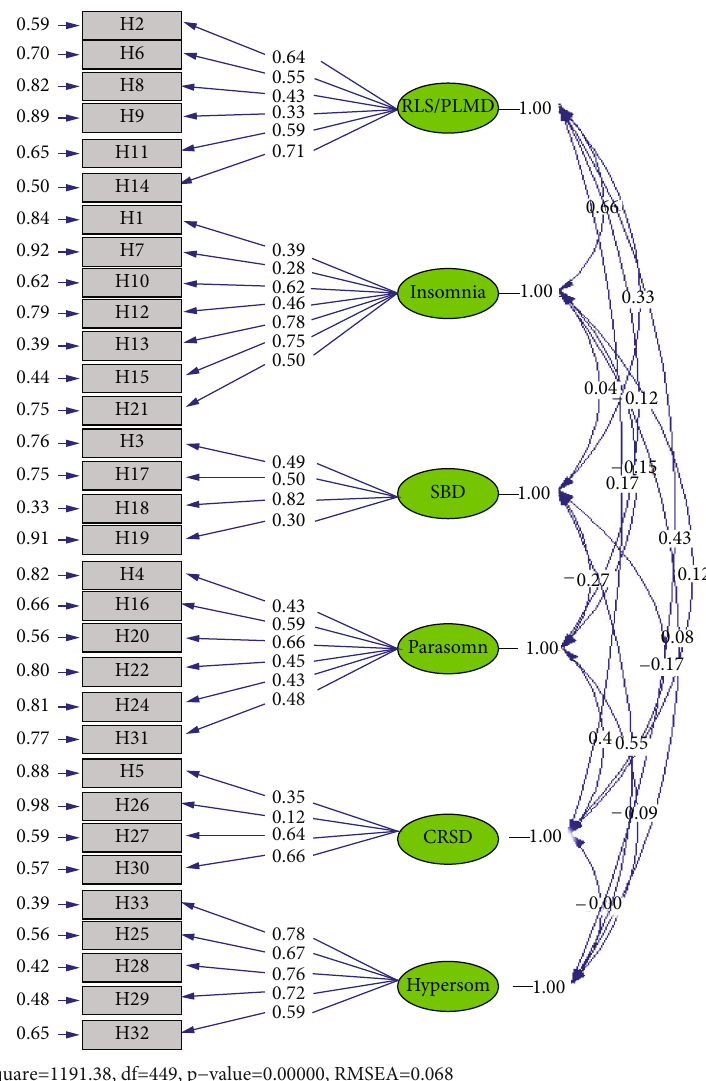
Figure 2: The six-factor model of the HSDQ in the Iranian population standard. CRSD: Circadian rhythm sleep disorders, RLS: restless legs syndrome, PLMD: periodic limb movement disorder; SDB: sleep-disordered breathing; HGDQ: Holland Sleep Disorders Questionnaire. Table 6: Fit indicators con fi rmatory factor analysis HSDQ. Fit indicators